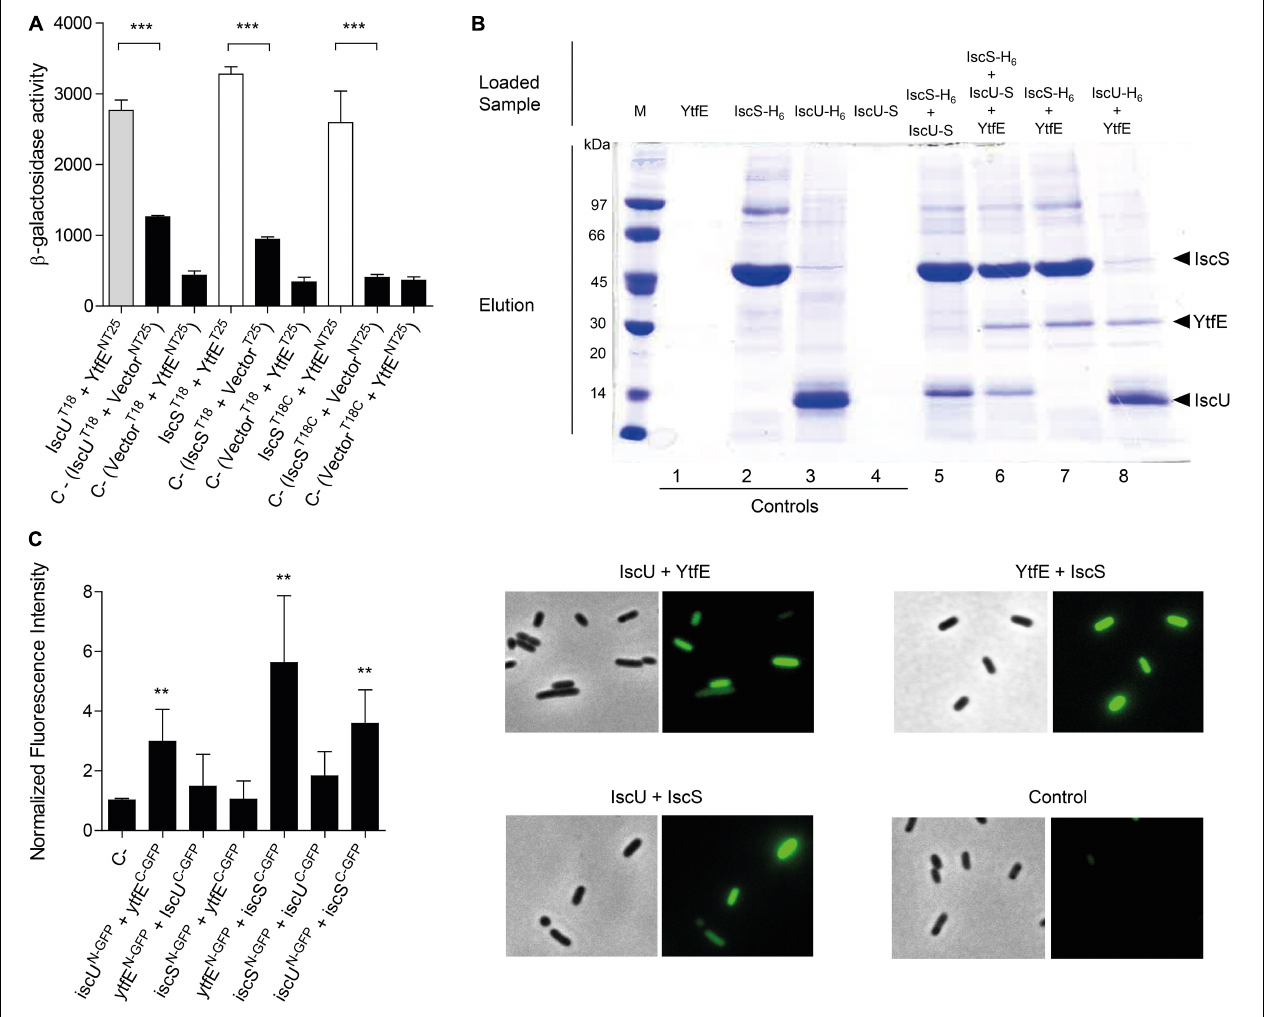
FIGURE 1 | Analysis of the interaction of YtfE with IscS and IscU. (A) The efficiency of the functional complementation between hybrid proteins was measured by β -galactosidase assays. The interaction of YtfE with IscU (gray bar) and IscS (white bars) was evaluated in E. coli cells co-transformed with plasmids containing either iscU or iscS genes cloned at the N - or C -terminal of the T18 fragment (T18/T18C), and the plasmid harboring the ytfE gene cloned at the N - or C -terminal of the T25 fragment (NT25/T25). T25/NT25 empty plasmids together with the T18/18C plasmid containing either the iscU or the iscS gene or T18/18C empty plasmid with NT25/T5 harboring ytfE were utilized as negative controls (black bars). Values are means ± standard errors from at least three independent cultures analyzed in duplicate. *** P < 0.0001; (B) For pulldown assays of YtfE, IscS and IscU, samples were obtained from cell extracts expressing one, two or three proteins previously treated with 1% formaldehyde and loaded in Ni-chelating columns, eluted with 1 M imidazole buffer, and subjected to SDS-PAGE. Lanes 1–4: control samples from extracts expressing only one protein. Lanes 5–8: co-purification of IscS with IscU (5); co-purification of YtfE and IscU with IscS (6); co-purification of IscS with YtfE (7); and co-purification of IscU with YtfE (8); and (C) In BiCF of YtfE and ISC proteins, cells were co-transformed with vectors expressing YtfE and IscS or IscU – GFP fusions. Cells harboring empty plasmids were used as controls. On the left, fluorescence quantification was performed using MetaMorph Microscopy Automation and Image Analysis Software. Fluorescence values for the negative control (empty plasmid vectors) were normalized to 1. ** P < 0.005. On the right microscope images (Bright field phase and FITC) of Negative control; iscU N − GFP + YtfE C − GFP ; ytfE N − GFP + IscS C − GFP ; and iscU N − GFP + IscS C − GFP . Values are means ± standard errors from at least three independent cultures analyzed in